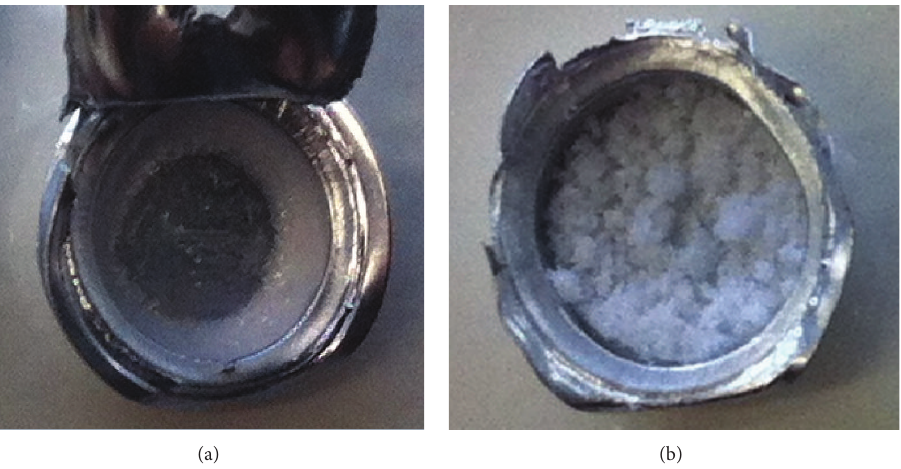
Figure 5: Images of the free octadecane (a) and encapsulated octadecane (b) after DSC treatments.